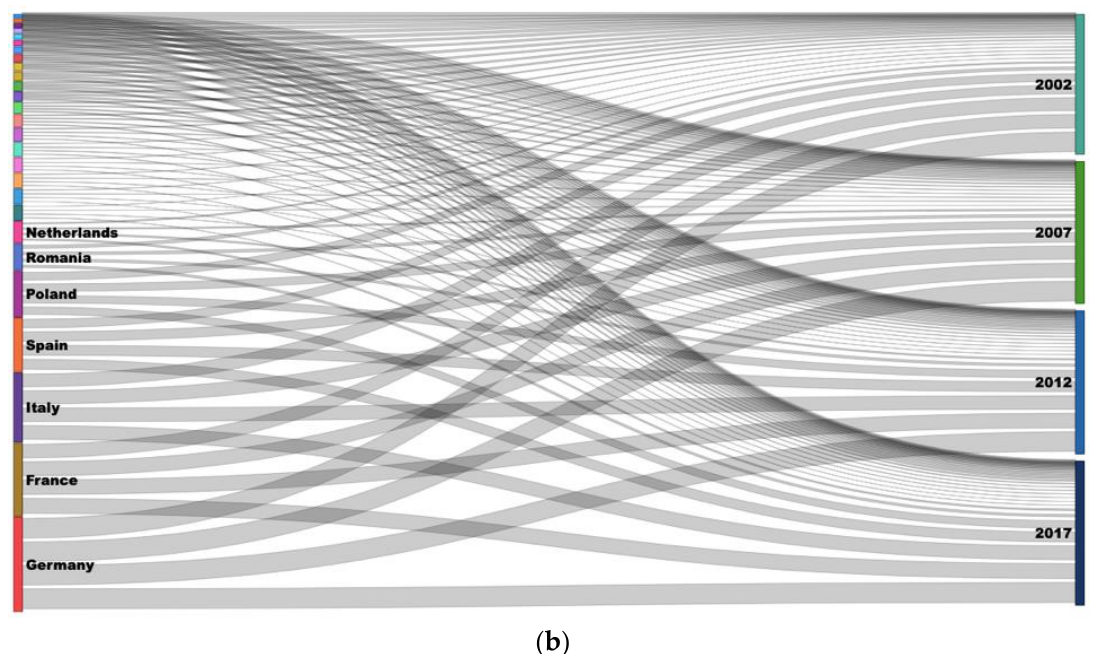
Figure 4. GDP and total population of EU countries. Note: ( a ) GDP, ( b ) Total population. Source: built based on AQUASTAT data [4].